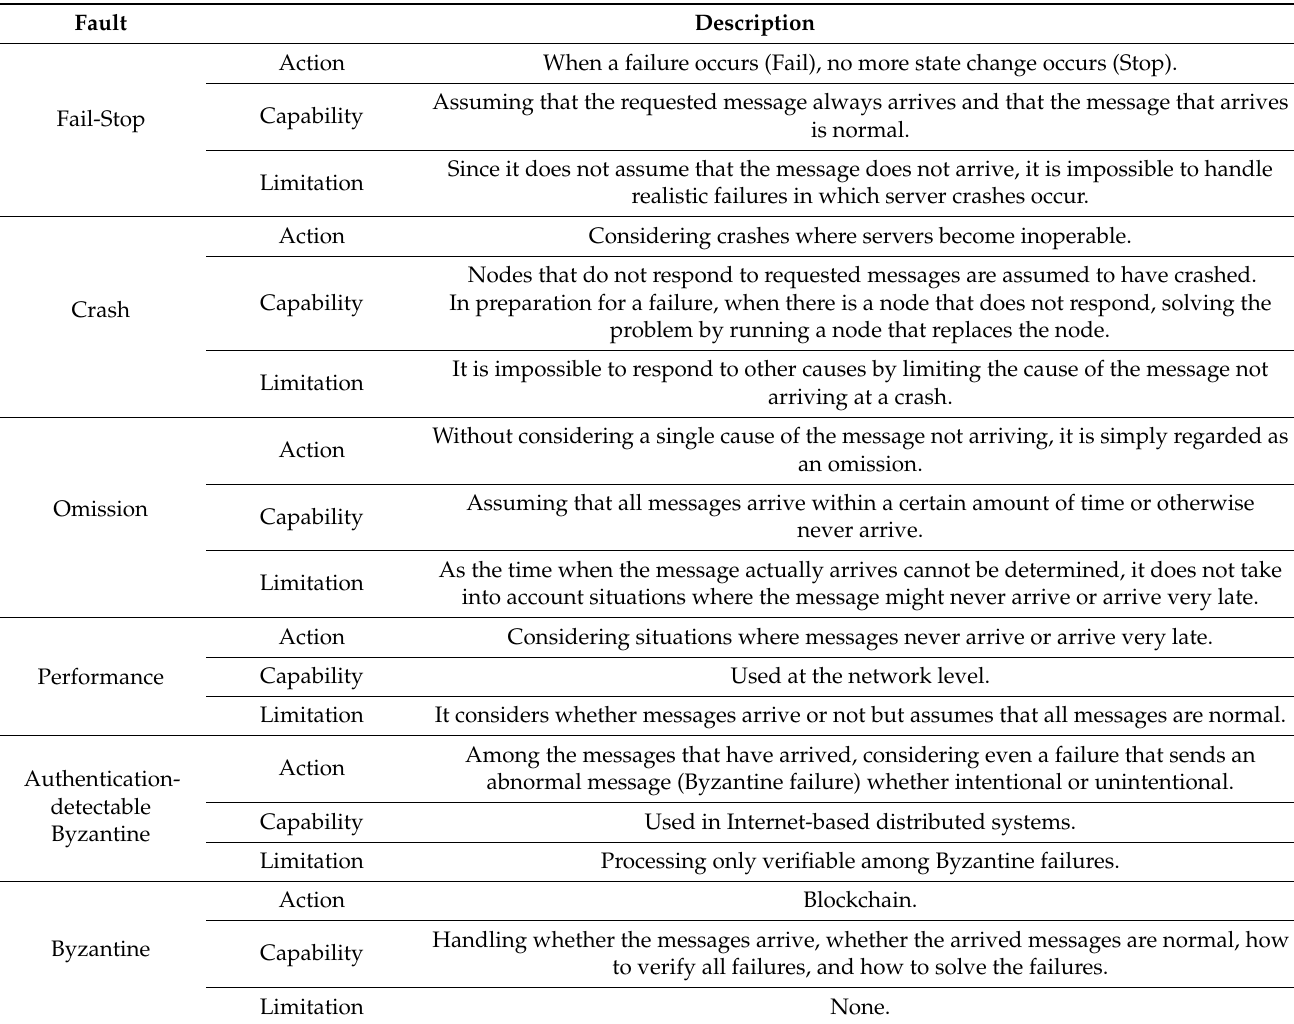
Table A1. The Model of Six Layers of